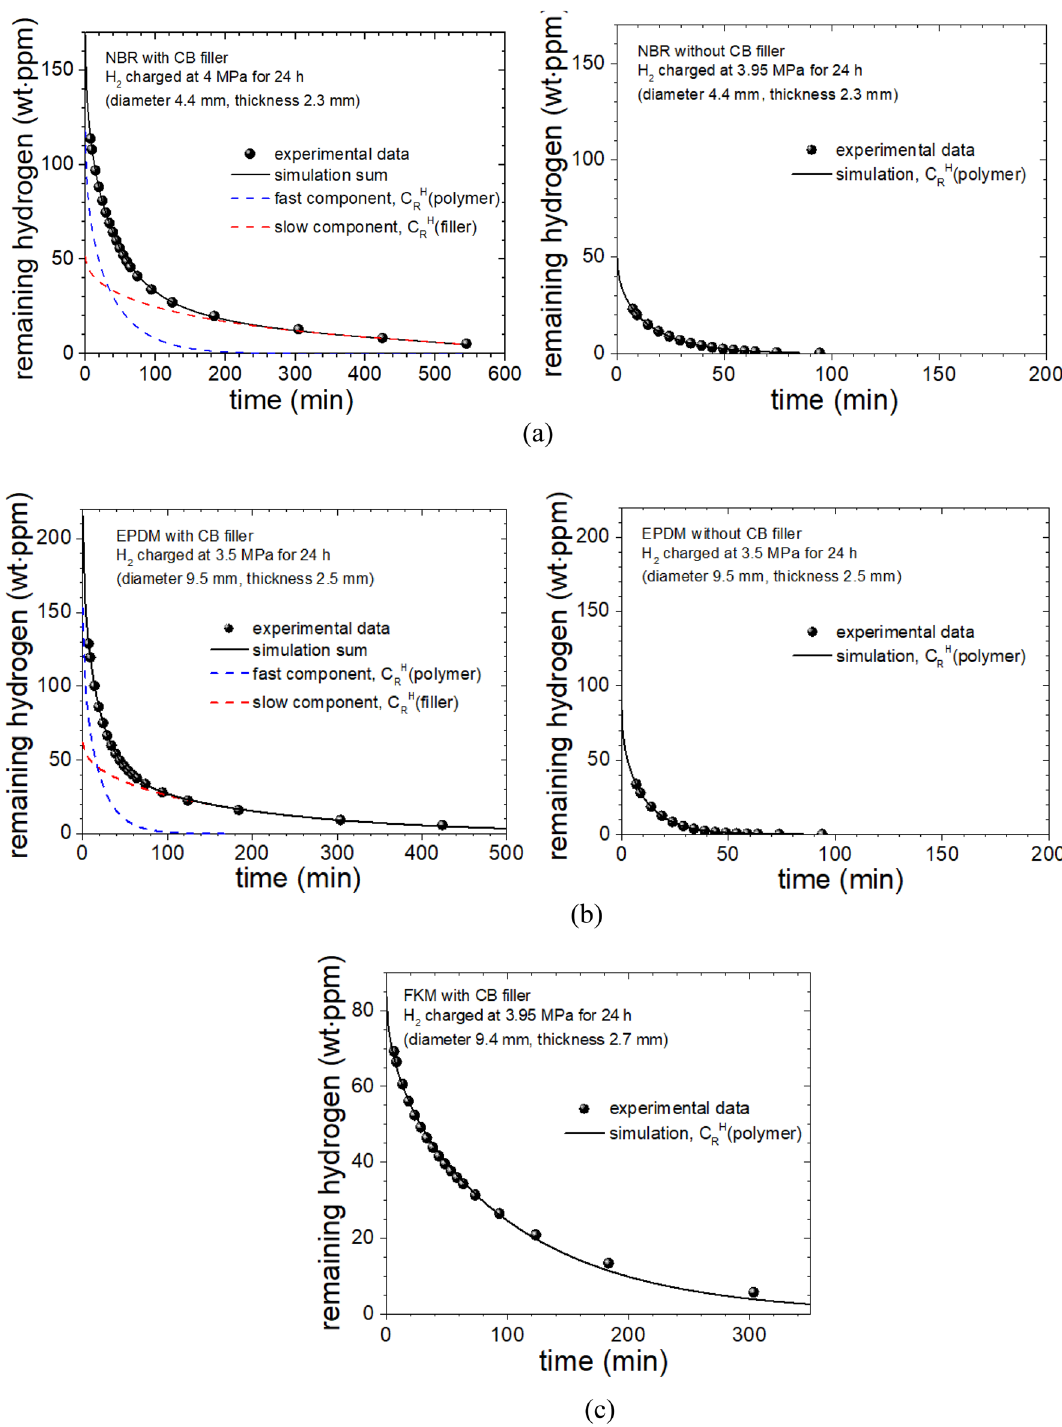
Figure 8. ( a ) Behaviors of remaining H 2 contents versus time in NBR sample with CB filler (left) and without CB filler (right). ( b ) Behaviors of remaining H 2 contents versus time in EPDM specimen with CB filler (left) and without CB filler (right). ( c ) Diffusion behaviors of residual H 2 contents over time in FKM sample with CB filler. Black solid line is the fitted line using one diffusivity with a single Eq.